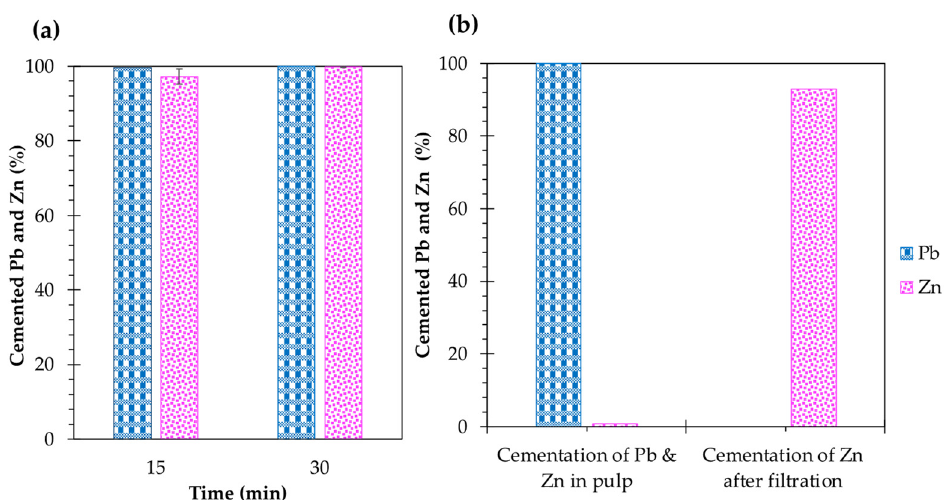
Figure 7. Amounts of Pb and Zn cemented out from ( a ) 3 M NaOH model solution containing Pb and Zn ions and treated for 15 and 30 min, and ( b ) concurrent cementation of dissolved Pb and Zn ions and cementation of Zn in the filtrate solution after concurrent cementation experiment (for interpretation of the references to color in this figure legend, the reader is referred to the web version of this article) .